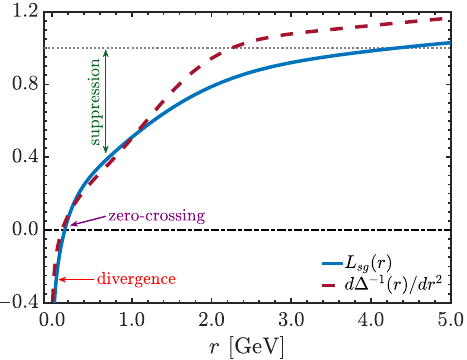
Figure 18. Comparison of L sg ( r ) (blue continuous) from Figure 11 and d ∆ − 1 ( r ) / dr 2 (red dashed) resulting from the fit for ∆ ( r ) of Figure 9. Note that both display the characteristic features of infrared suppression with respect to their tree-level values (which is 1 for both quantities), zero-crossing, and logarithmic divergence at the